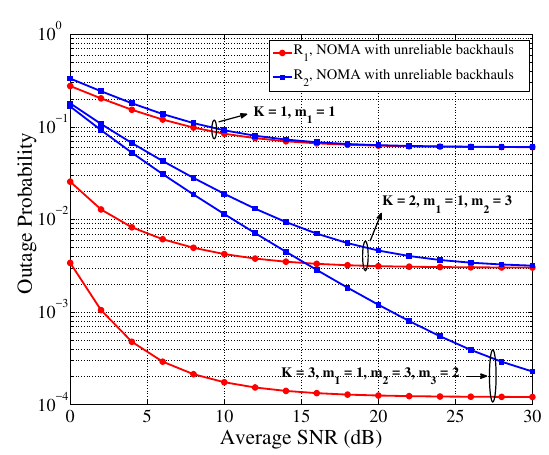
Figure 3. Outage probability of NOMA under unreliable backhauls with opportunistic SS based on far-away receiver, R